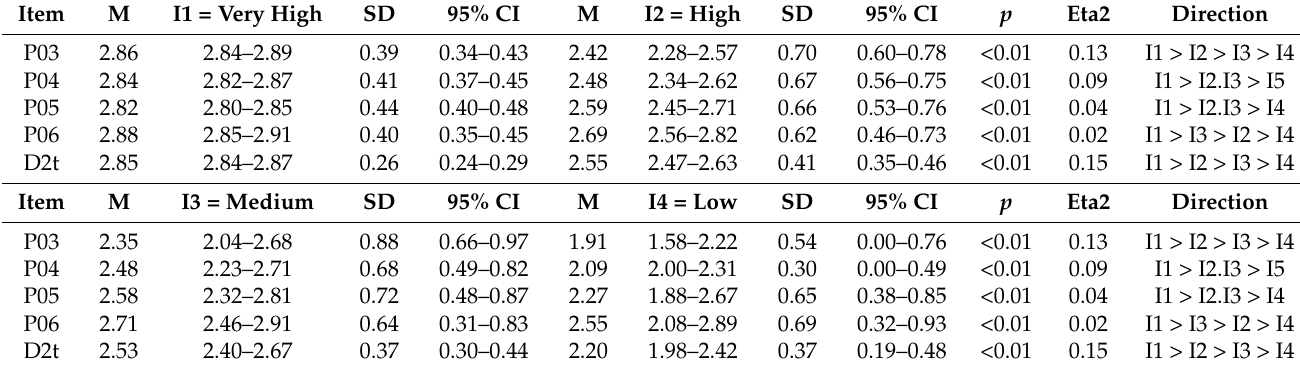
Table 10. ANOVA for independent samples by Human Development Index for dimension